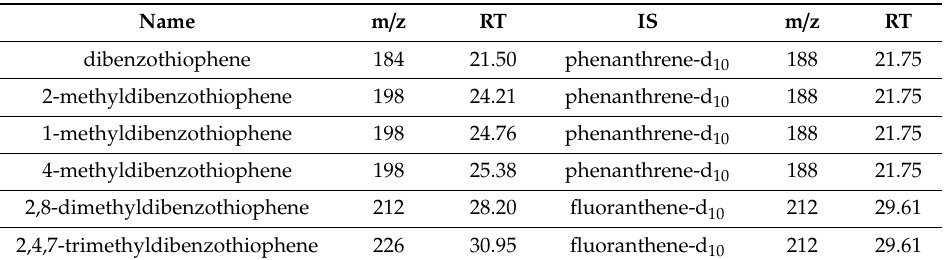
Table A2. Transitions and retention times of dibenzothiophenes (DBTs) and deuterium labeled internal standards (IS) and recovery standard (RS) used. Analysis was performed, using electron impact ionization (EI).